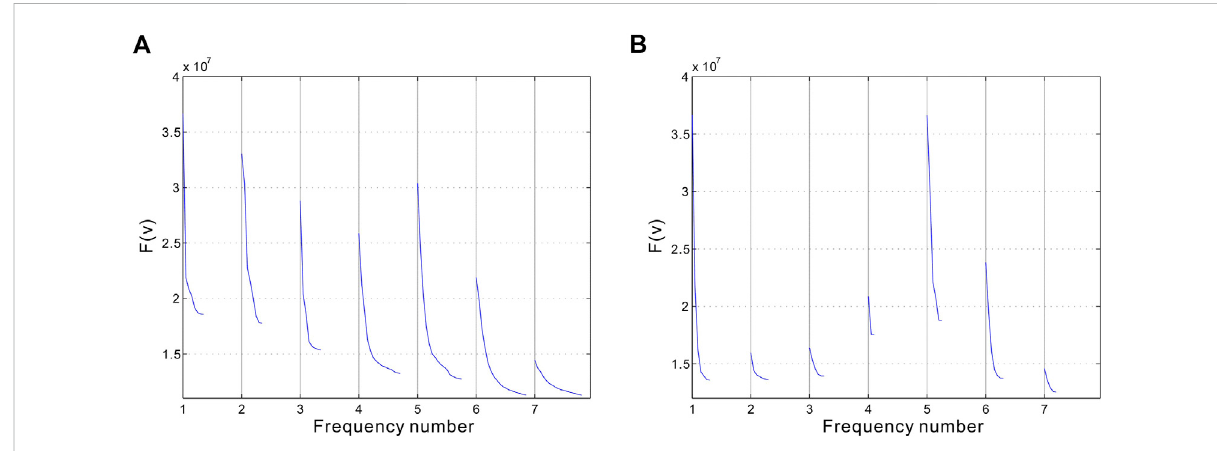
FIGURE 10 The convergence curves of (A) L-BFGS method and (B) mL-BFGS method of the Overthrust model test with noise-added